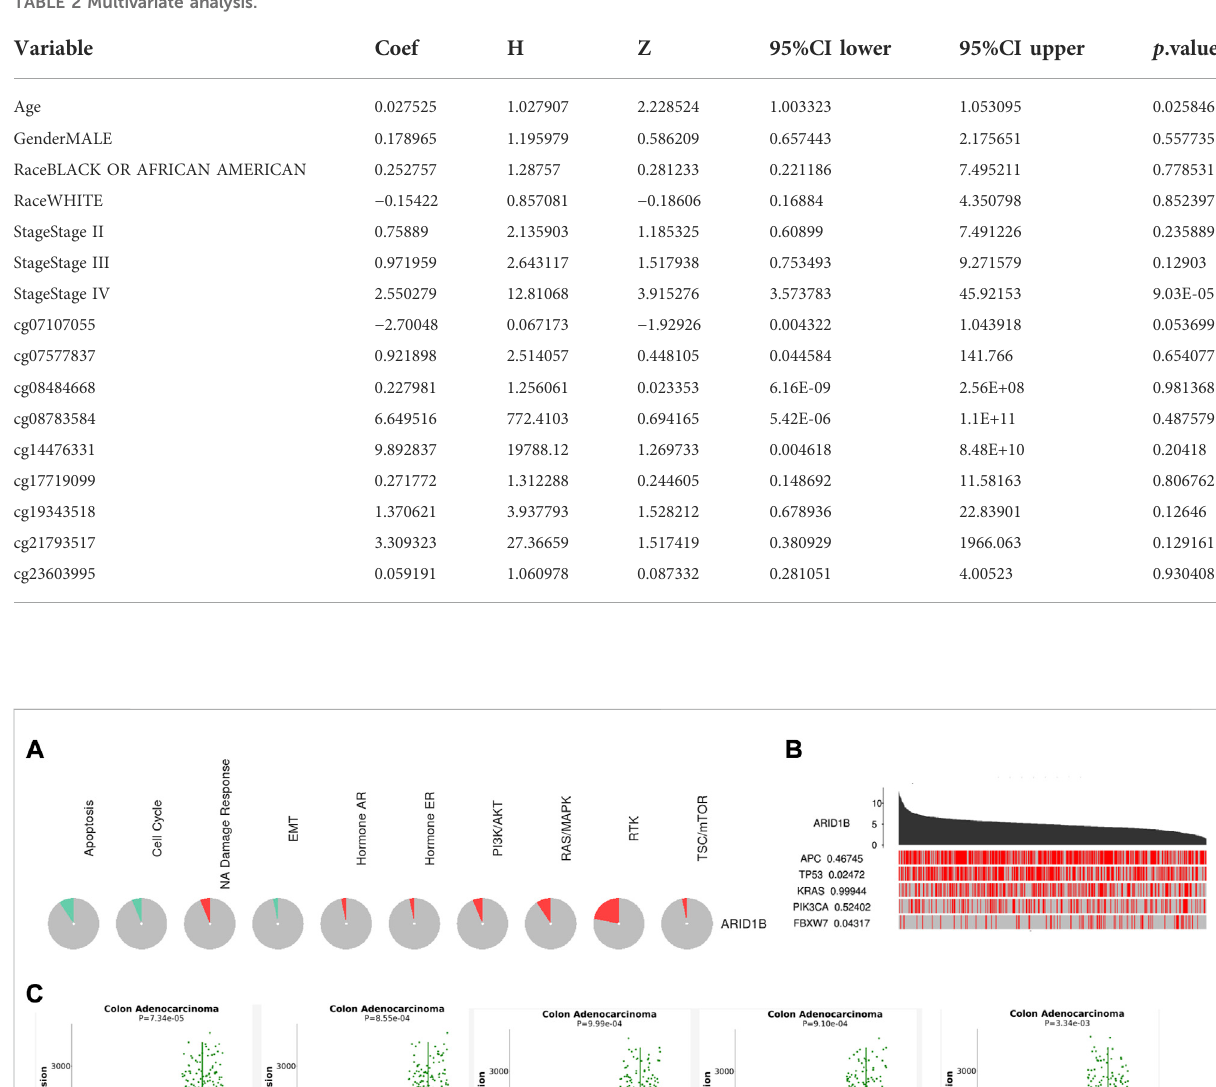
TABLE 2 Multivariate analysis.